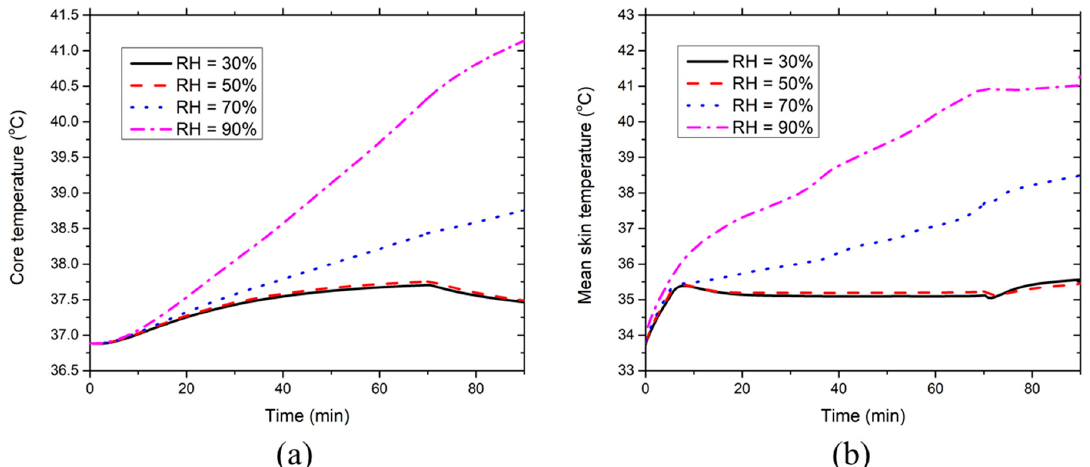
Figure 12. Effect of environmental RH on the time course of ( a ) core temperature and ( b ) mean skin temperature at the ambient temperature of 40 °C.